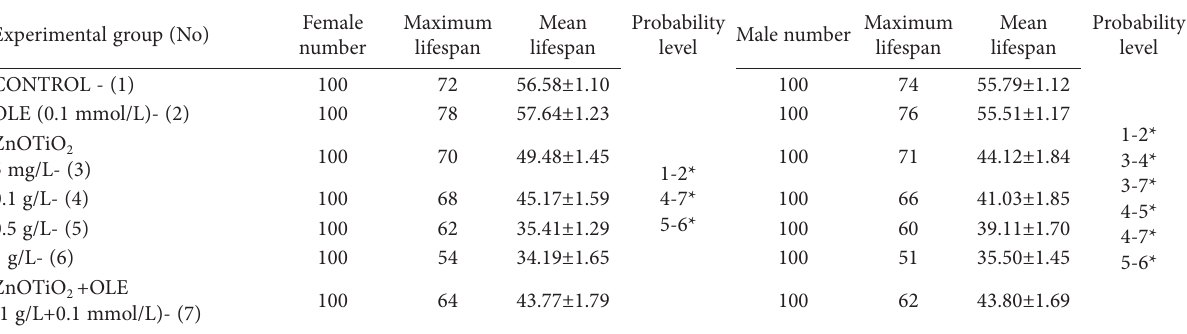
Table 1. Th e longevity of male and female populations of D. melanogaster Experimental group